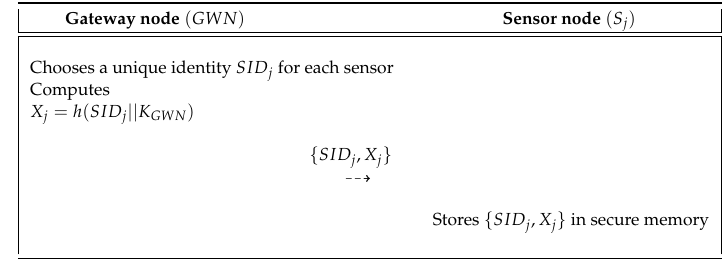
Figure 4. Pre-deployment process of the proposed scheme.